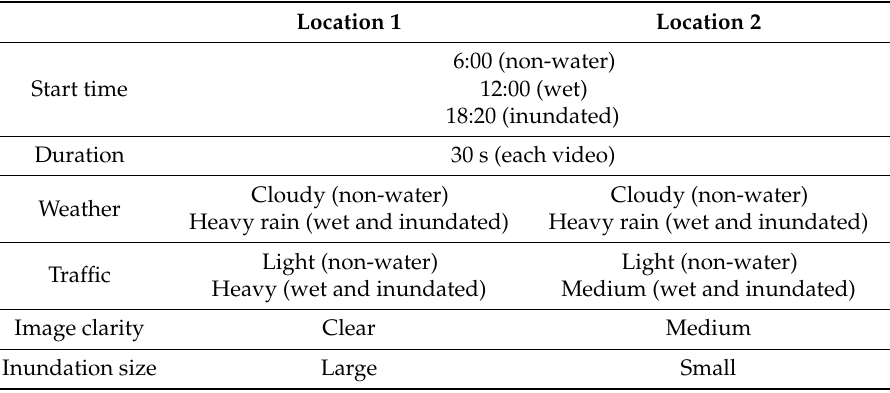
Table 1. Video Data Properties.